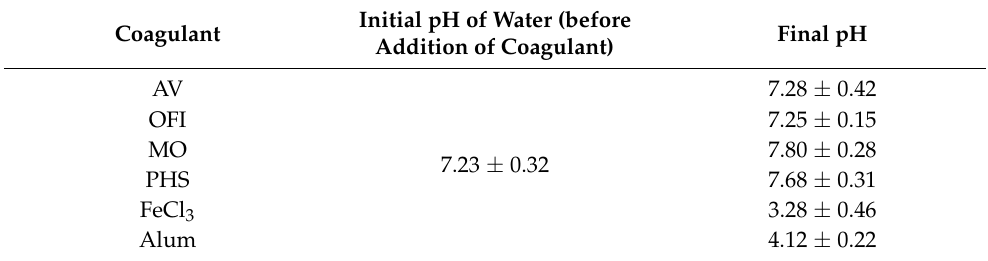
Table 4. Values of pH of water samples treated with the coagulants (mean ± SD, n = 3). Initial pH of Water (before Coagulant Addition of